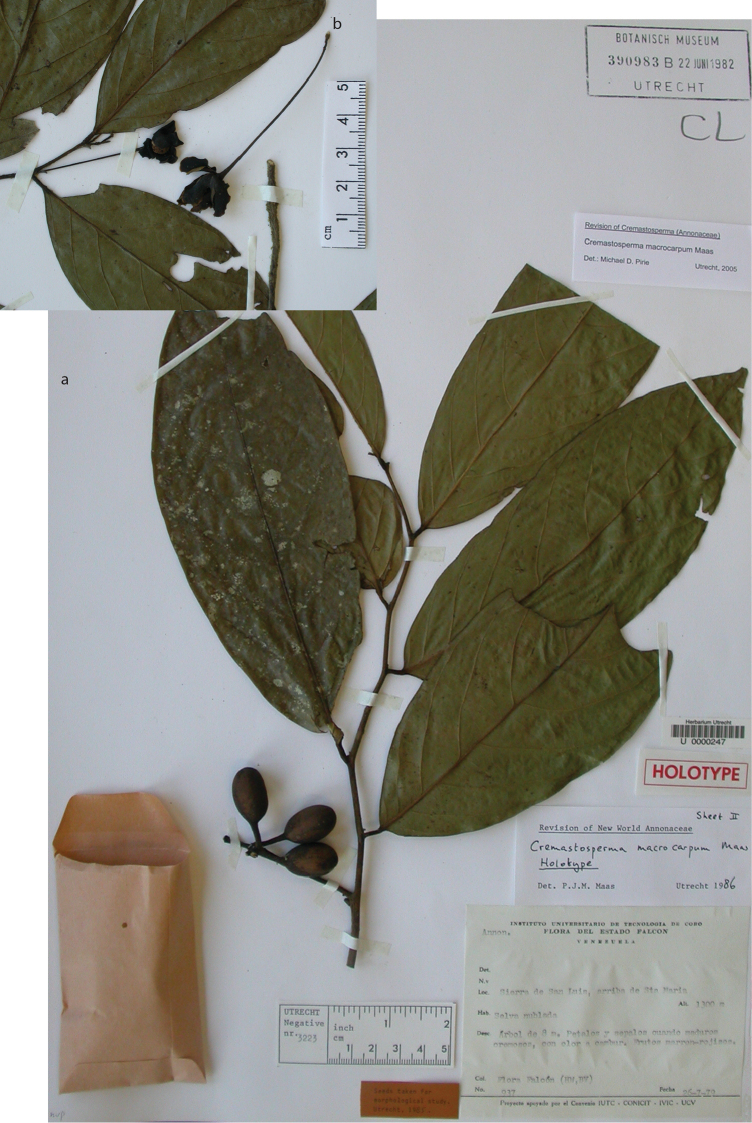
Cremastospermamacrocarpum Maas. a fruiting specimen b flower (a, bvan der Werff & Vera, Flora Falcón 937).